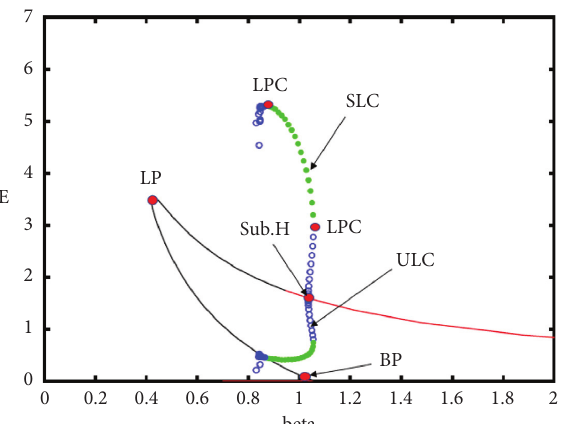
Figure 2: One-parameter bifurcation diagram of exposed individuals ( E ) with transmission rate ( β ) as a bifurcation parameter. The fixed parameters are μ � 0 . 18, Λ � 4, p � 0 . 5, κ � 0 . 03, c � 0.02, b � 0.2, δ � 0 . 08, and τ � 2. The Hopf bifurcation points occurred at β � 1 . 035. Sub · H corresponds to subcritical Hopf bifurcation, LPC corresponds to saddle-node bifurcation of cycles, LP corresponds to saddle-node bifurcation, BP corresponds to transcritical bifurcation, SLC corresponds to stable limit cycle, and ULC corresponds to unstable limit cycle.